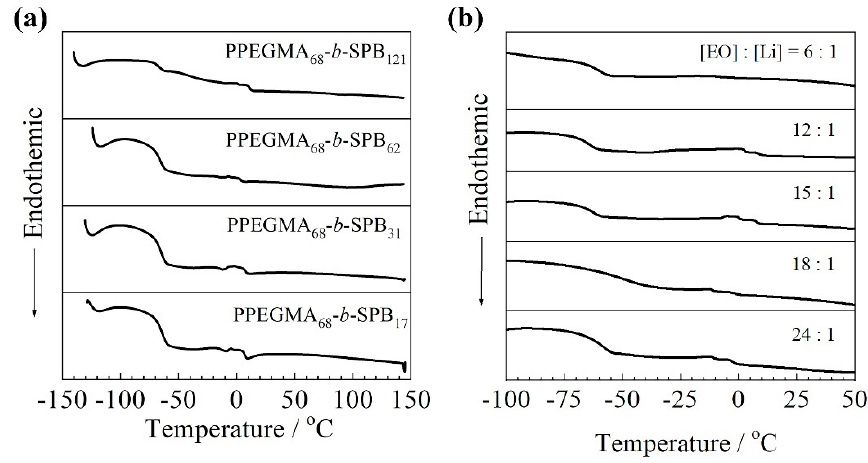
Figure 2. DSC traces of ( a ) PPEGMA 68 - b -SPB m and ( b ) PPEGMA 68 - b -SPB 121 /LiTFSA composites (2nd heating).